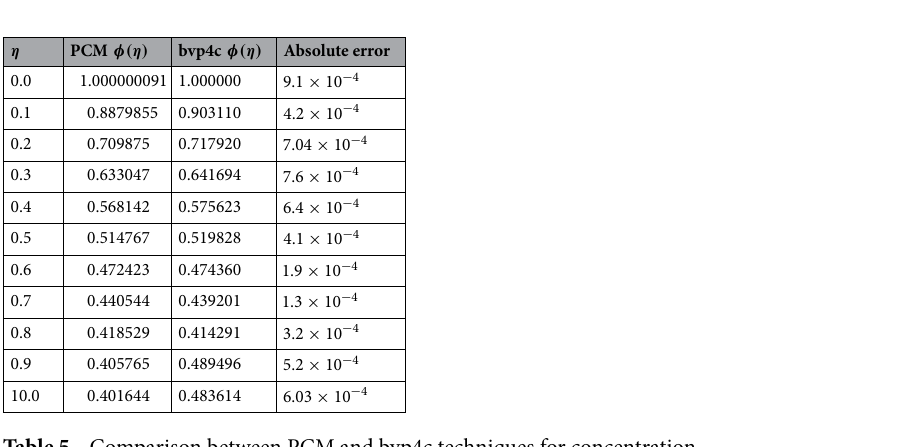
Table 5. Comparison between PCM and bvp4c techniques for